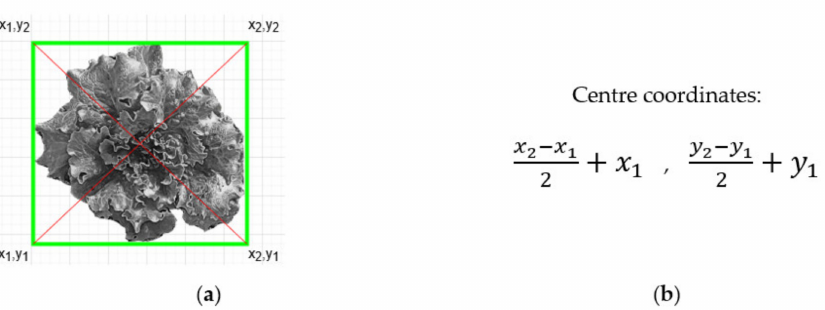
Figure 19. ( a ) Schematic representation of the exporting of the bounding boxes’ centers and; ( b ) Equation used to extract the centre’s coordinates.